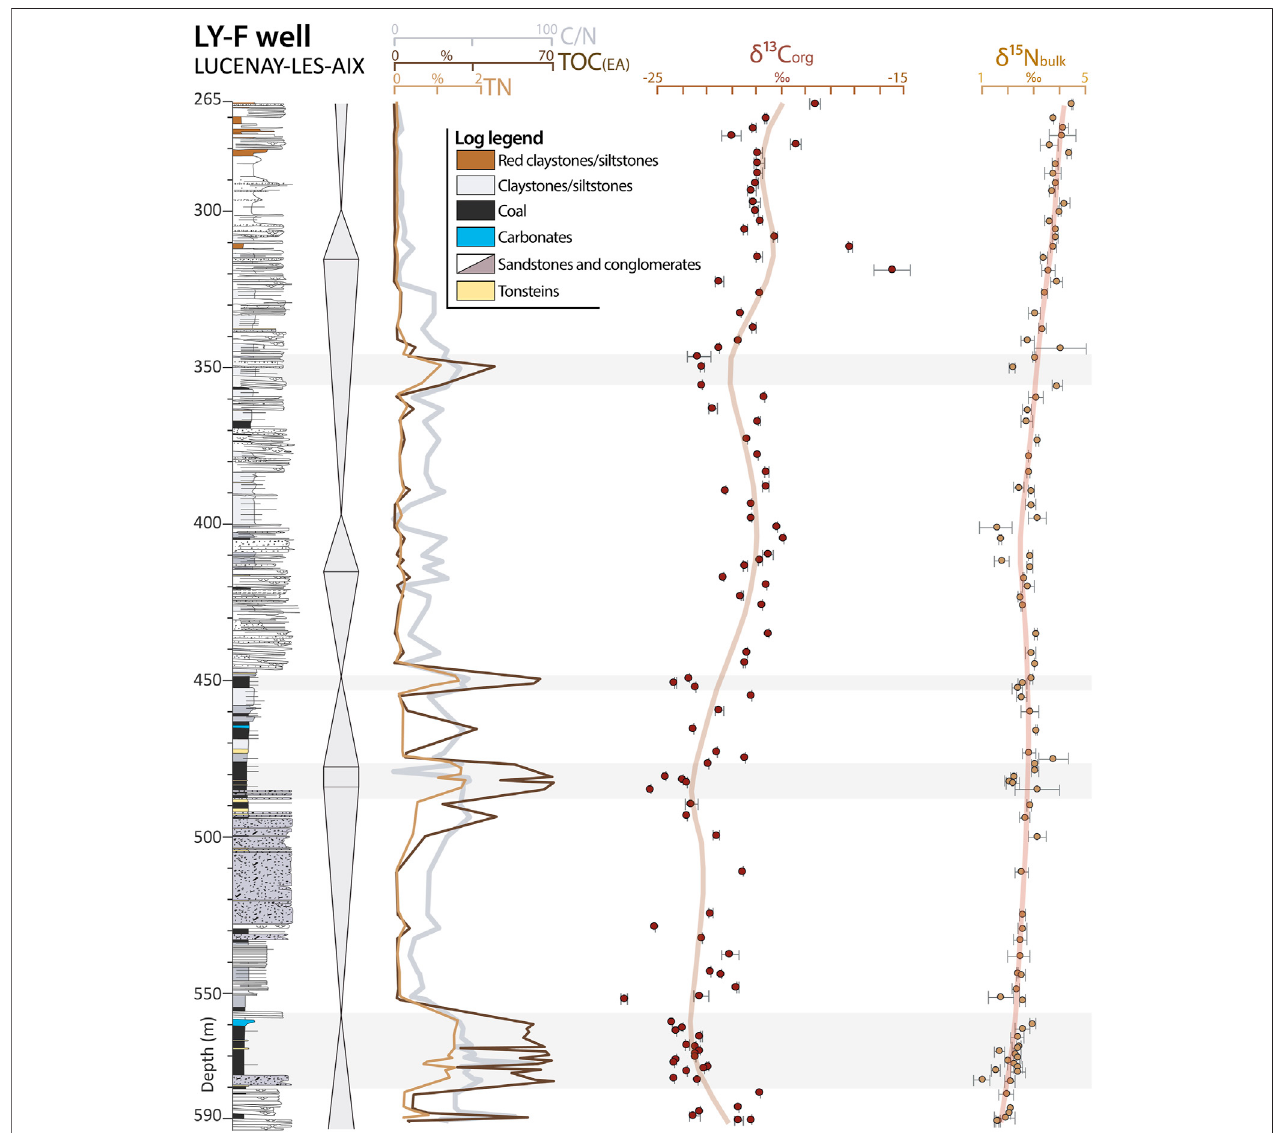
FIGURE9| Sedimentary section, sequencestratigraphyoftheLY-Fcore(Lucenay-lès-Aixarea,Decize – LaMachineBasin)andorganicsignalevolution(TOC, TN, C/N atomic ratio, δ 13 C org and δ 15 N bulk variations). The log caption is displayed on Figure 2 .